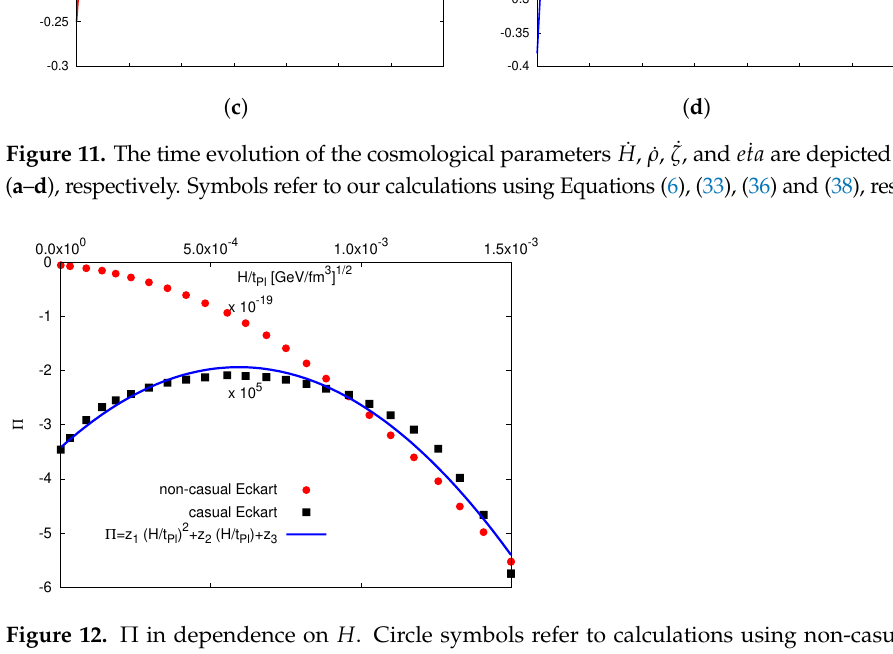
Figure 12. Π in dependence on H . Circle symbols refer to calculations using non-casual Eckart theory while square symbols refer to calculations using casual Eckart theory. Solid curve refers to the proposed expression for the dependence of Π on H